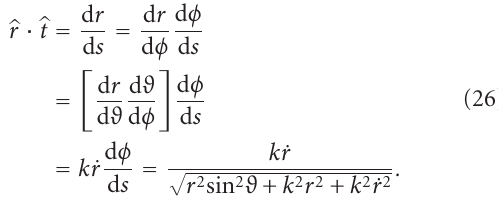
d φ d r d r (cid:6) r · (cid:6) t = = d s d φ d